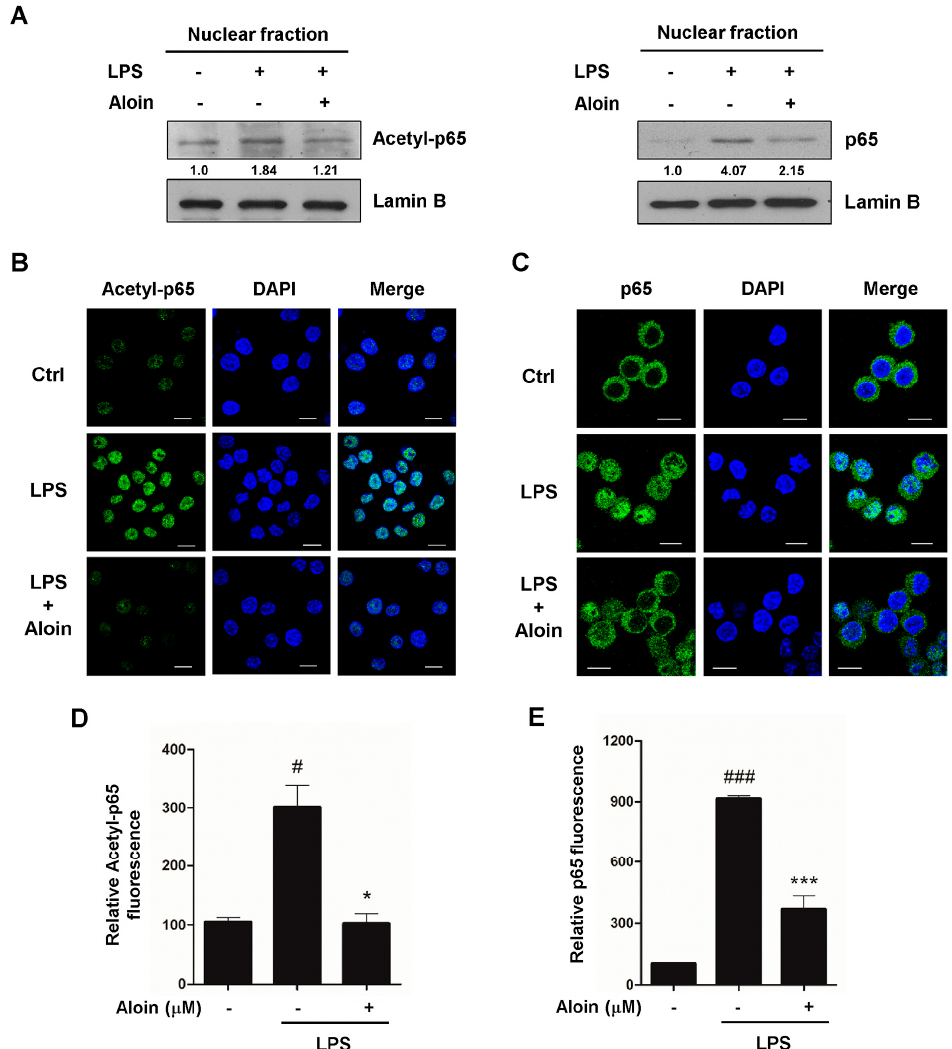
Figure 5. Aloin inhibits LPS-induced NF- κ B p65 nuclear translocation. ( A ) RAW 264.7 cells were pre-treated with or without aloin (400 µ M) for 2 h, and then stimulated with LPS (100 ng/mL) for 2 h. Protein levels of acetylated p65 and total p65 in the nuclear fractions were analyzed by immunoblotting. Lamin B was used as a marker for nuclear fraction. RAW 264.7 cells treated with or without aloin and LPS were fixed and immunostained with ( B ) acetylated p65 or ( C ) total p65 antibodies, and fluorescent images were captured by confocal microscopy. Scale bar, 10 µ m. At least 200 cells were counted for each sample; ( D ) Quantification of acetyl-p65 and ( E ) total p65 fluorescent intensities in RAW 264.7 cells. Data shown are the means ± SD of three experiments. # p < 0.05 and ### p < 0.001 are different from the control. * p < 0.05 and *** p < 0.001 are different from the LPS alone.